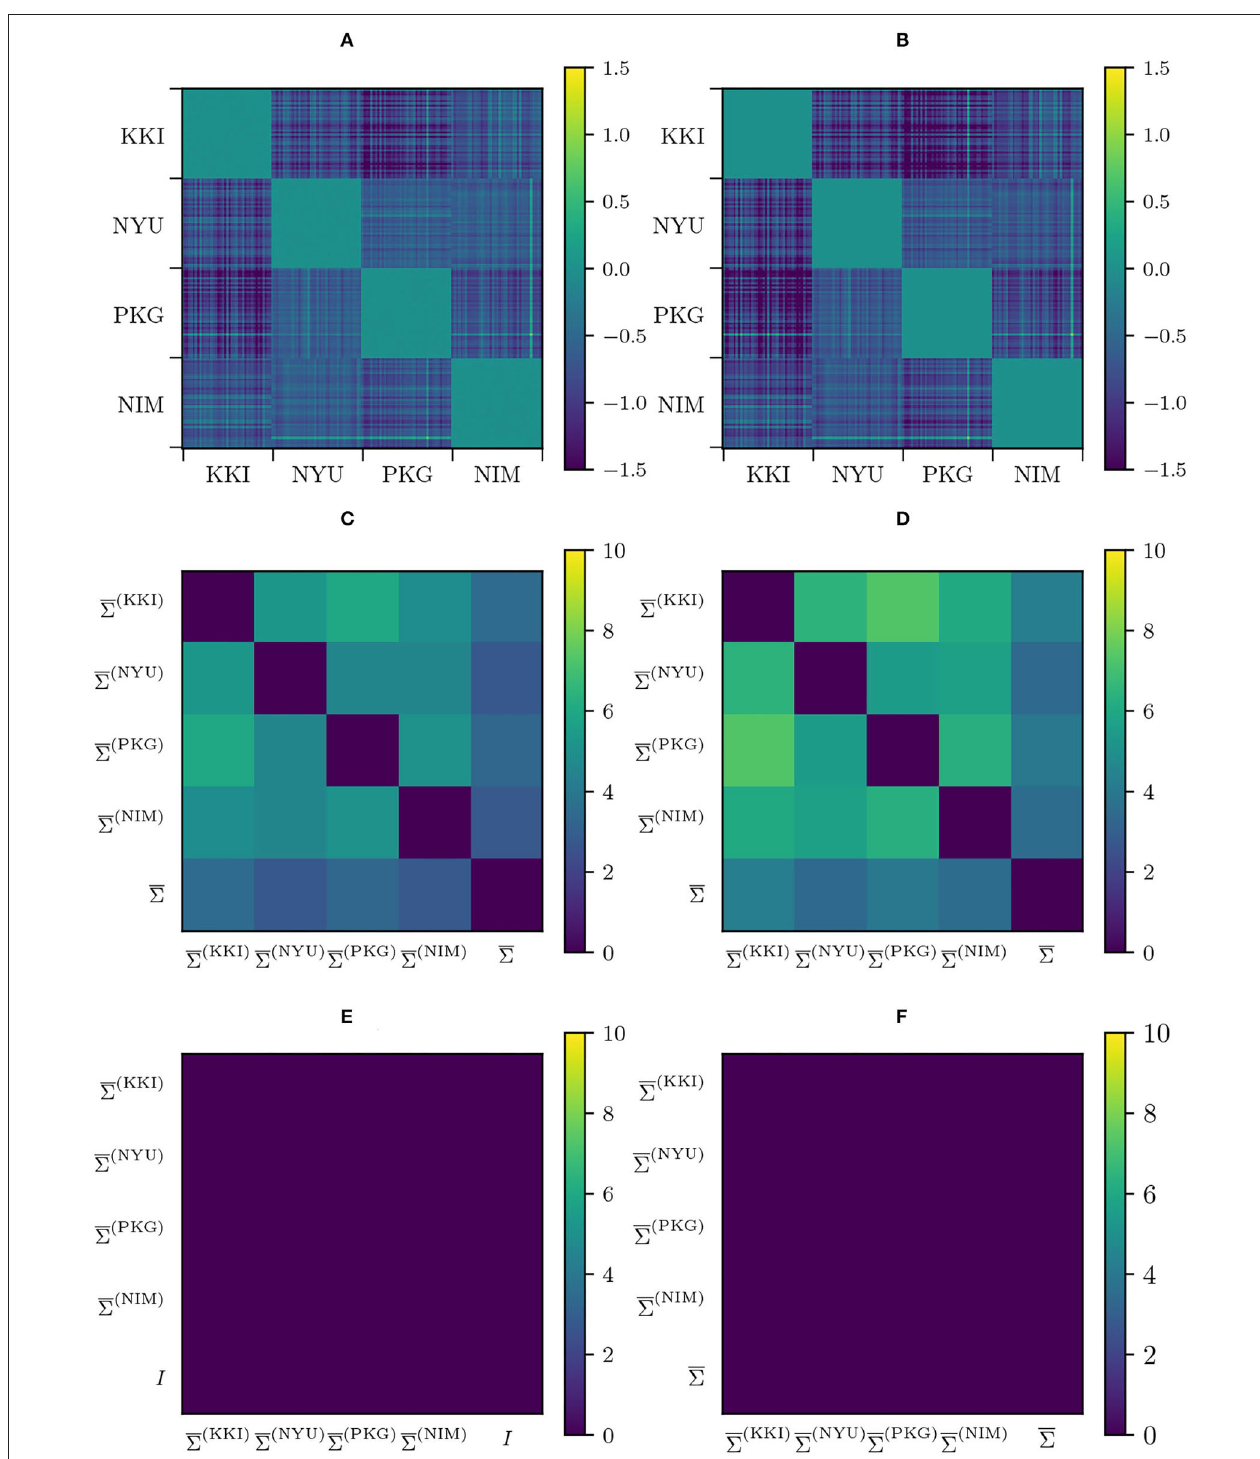
FIGURE 5 | (A) Difference in pair-wise AIRM distances between original matrices and matrices transformed under matrix whitening. (B) Difference in pair-wise LERM distances between original matrices and matrices transformed under Rigid Log-Euclidean Translation (RLET). (C) Pair-wise AIRM distances between site Fréchet means { 6 ( k ) } and the global mean 6 . (D) Pair-wise LERM distances between site Fréchet means 6 ( k ) and the global mean 6 . (E) Pair-wise AIRM distances between site Fréchet mean computed after matrix whitening and the identity matrix I . (F) Pair-wise LERM distances between site Fréchet means computed after RLET( 6 ) and the global mean 6 . KKI, Kennedy Krieger Institute, Johns Hopkins University; NYU, New York University Child Study Center; PKG, Peking University; NIM, NeuroIMAGE